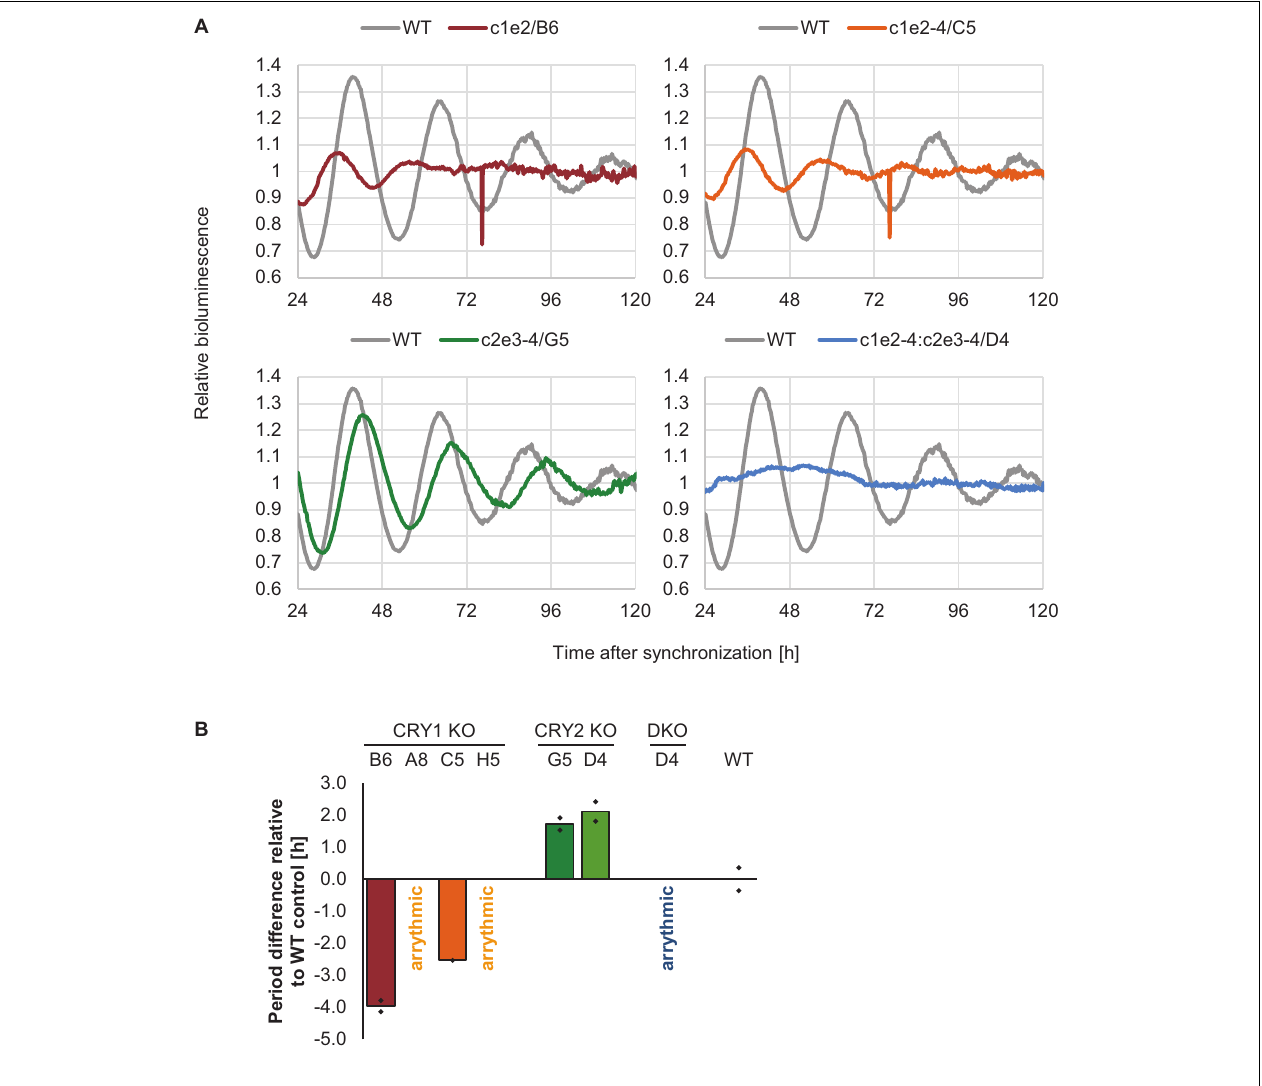
FIGURE 5 | Deletion of CRY proteins alters circadian dynamics. (A) Indicated single clones containing a Bmal1 -luciferase reporter were synchronized with dexamethasone, and bioluminescence rhythms were analyzed for several days. Shown are representative detrended time series. (B) Quantification of circadian period for indicated single cell clones (DKO = double knockout). Shown are means of two independent experiments with twelve technical replicas each (clone D5 was measured once with eight technical replicas). Dots indicate the two mean values of the two experiments.